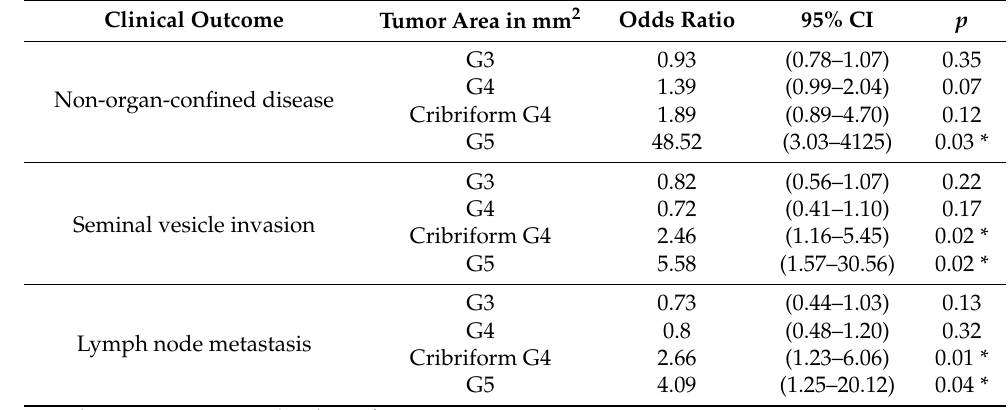
Table 8. Cross tabulation showing down- and upgrading of the biopsy session GG in the RALP specimen.